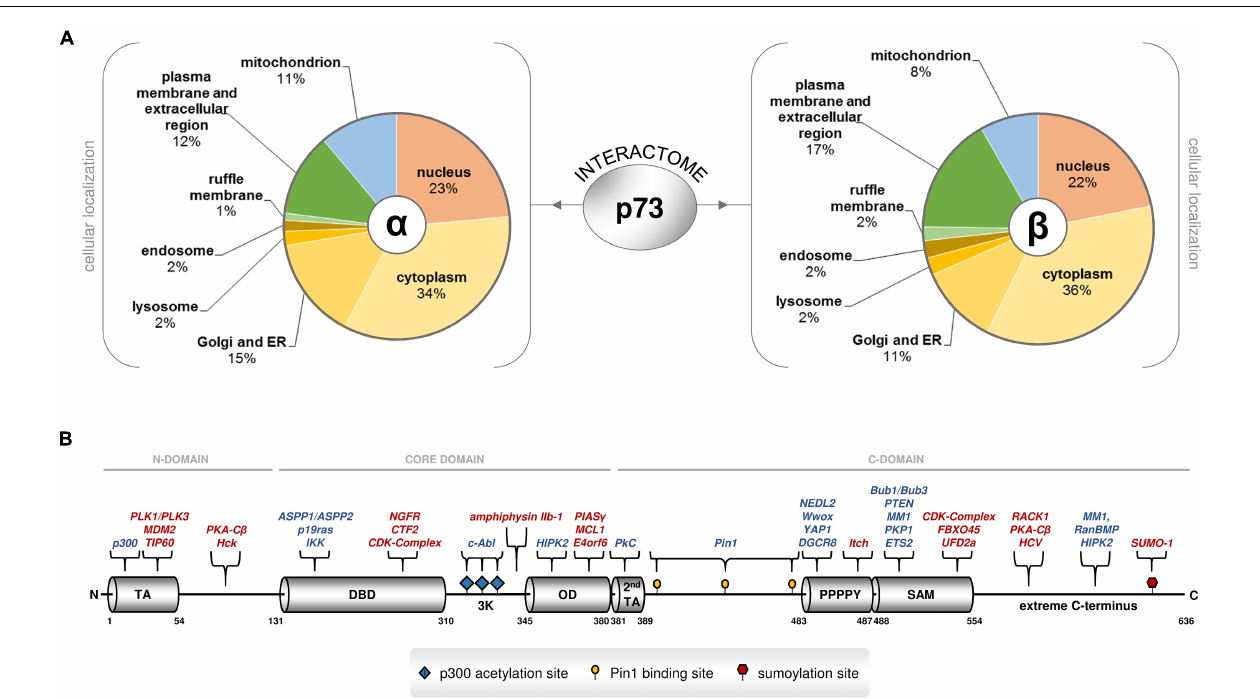
FIGURE 2 | Several proteins physically associate with p73 isoforms inside and outside the nucleus. (A) Analysis of the cellular localization of the p73alpha and beta interactome based on high-throughput coIP-MS screening in Saos-2 cells overexpressing TAp73alpha, (cid:49) TAp73alpha, TAp73beta, or (cid:49) TAp73beta. Protein annotation and subcellular distribution was retrieved from UniProt and DAVID GO. (B) The TP73 gene encodes a variety of functional motifs and crucial amino acid residues in the N-terminus, the core domain, and the C-terminus that serve as selective interacting surfaces for the p73 proteome. The C-terminus is particularly enriched in such protein-binding sites. Each p73 isoform contains unique combinations of these protein-binding sites. Annotations: TA transactivation domain, DBD DNA binding domain, OD oligomerization domain, 3K p300 acetylation sites, 2nd TA second transactivation domain, SAM sterile alpha motif, extreme: extreme carboxy terminus. The literature-curated protein interactors that recognize the corresponding motifs and residues are also depicted. The proteins with inhibitory effect on p73 stability or activity are highlighted in